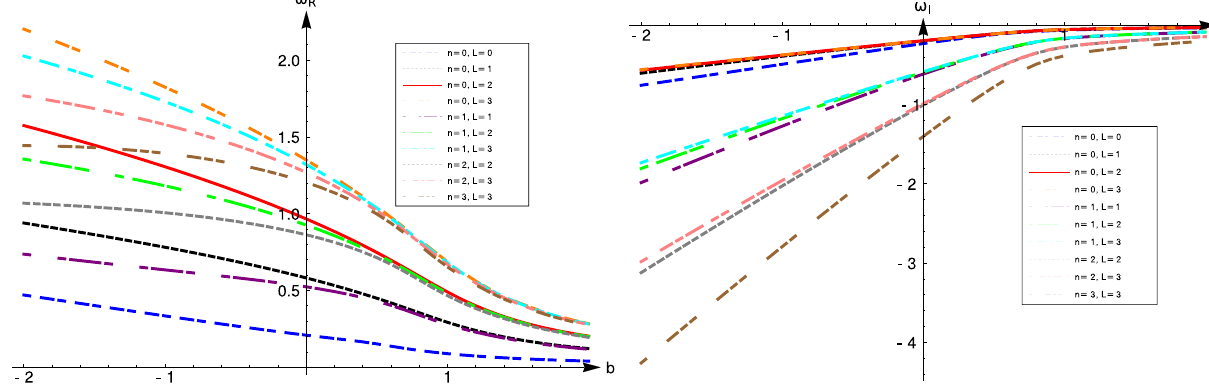
Fig. 12 Scalar quasinormal modes of the black hole for different values of angular (or multipole) quantum number L and overtone